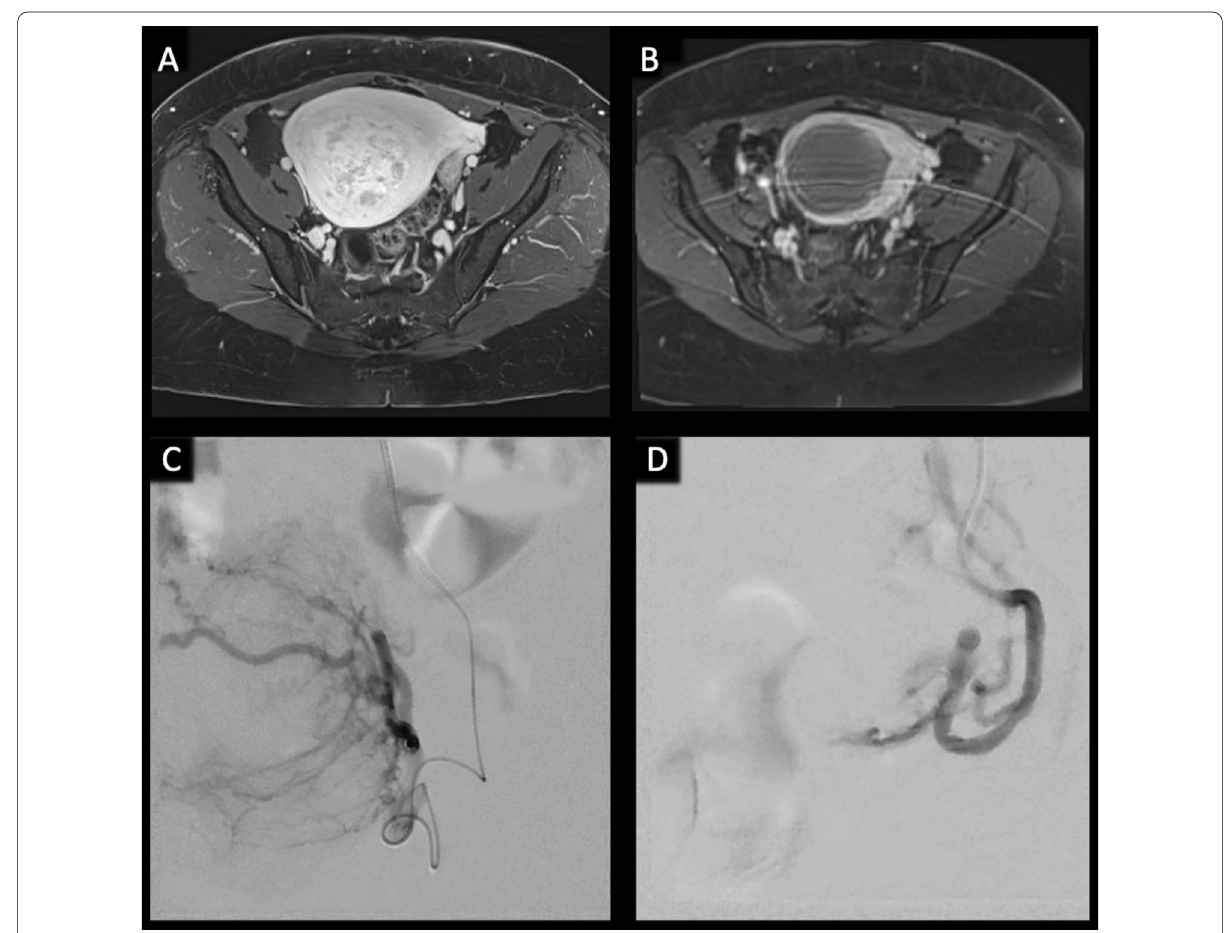
Fig. 1 UAE. T1-weighted contrast-enhanced MRI of the pelvis before ( A ) and after ( B ) UAE in a patient showing a good response to treatment. The hypointense areas in the center of the tumor mass indicate tumor necrosis. Digital subtraction angiography of the uterine artery before ( C ) and after ( D ) embolization showing stasis in the uterine